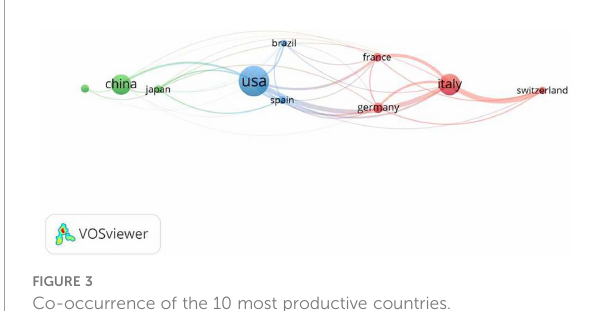
FIGURE 3 Co-occurrence of the 10 most productive